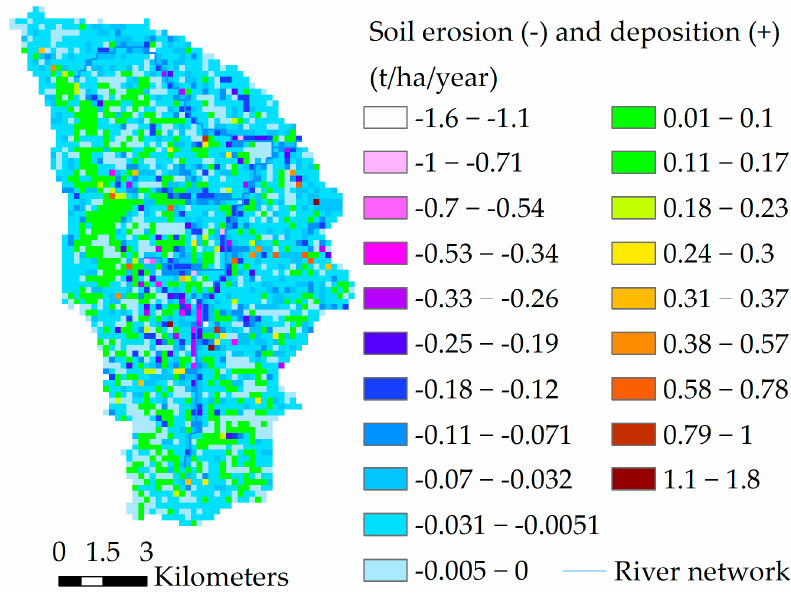
Figure 6. Annual soil erosion ( ‐ ) and deposition rate (+) on hillslopes as simulated for the Annual soil erosion (-) and deposition rate (+) on hillslopes as simulated for the calibration calibration period.